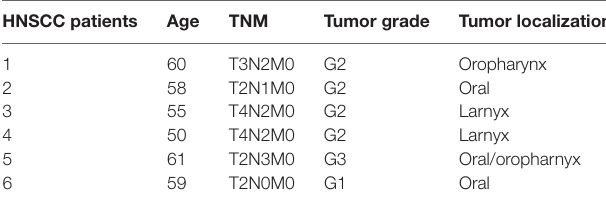
TaBle 1 | Head and neck squamous cell carcinomas (HNSCC) patients and healthy control